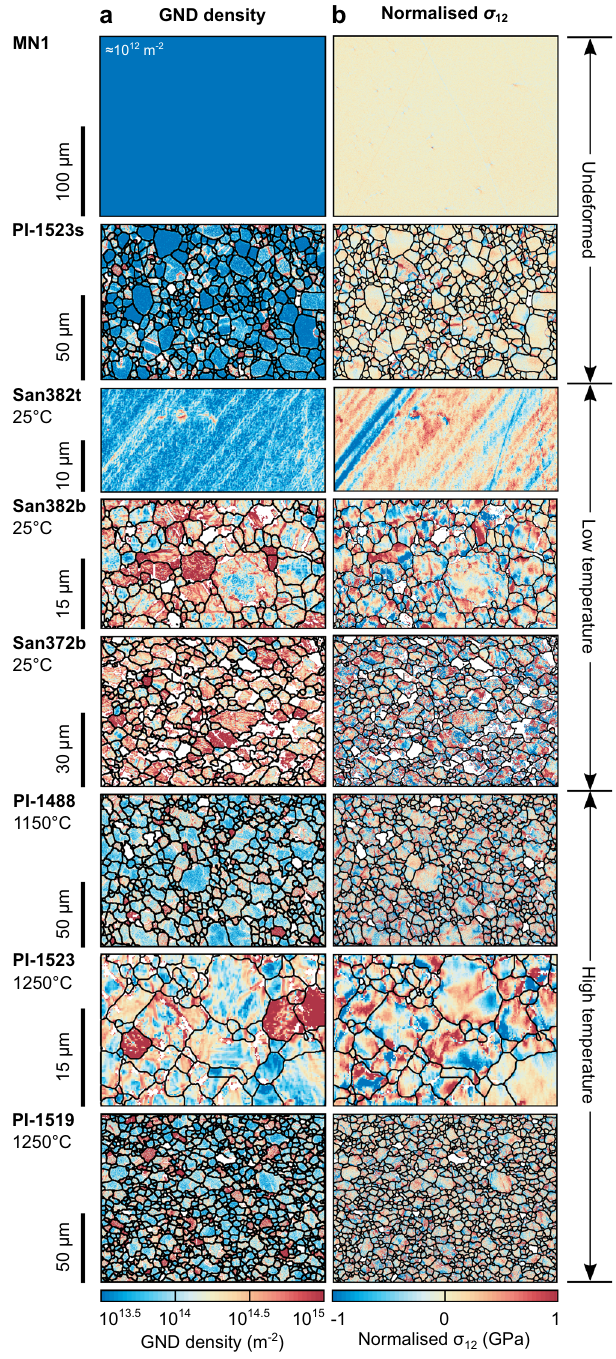
Fig. 1 Densities of geometrically necessary dislocations and stress heterogeneity. a Densities of geometrically necessary dislocations (GNDs) estimated from lattice rotations measured by HR-EBSD. Grains with apparent GND densities uniformly >10 15 m − 2 have orientations that result in high noise fl oors, obscuring the intragranular GND structures 40 . b Maps of σ 12 normalised by subtracting the mean value within each grain. Samples MN1 and San382t are single crystals, whereas all other samples are aggregates. Annotations indicate the sample number and fi nal deformation temperature. The compression direction was vertical in the maps of the deformed samples. White areas (<47% of map areas) were not indexed during EBSD acquisition or failed the cross-correlation quality criteria (Methods). Black lines mark grain boundaries with misorientation angles